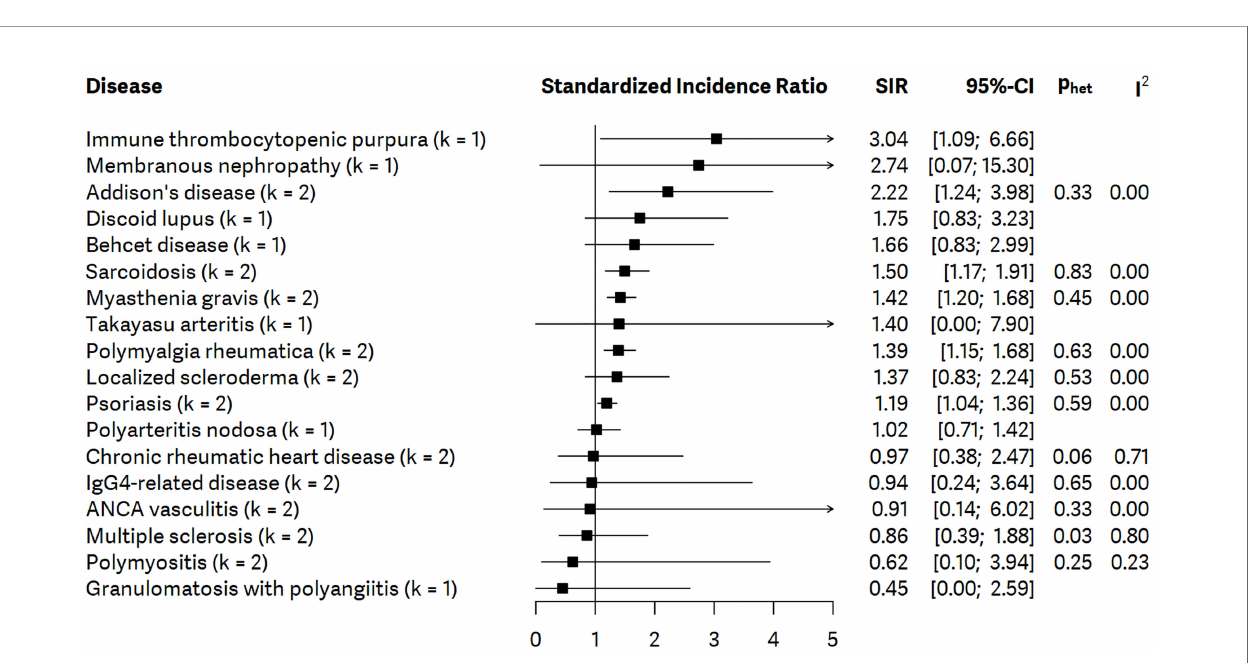
FIGURE 3 | Summarizing forest plot with pooled standardized incidence ratios (SIRs), representing the incidence of gastric cancer in all patients with autoimmune disorders included in qualitative synthesis; number of studies – k